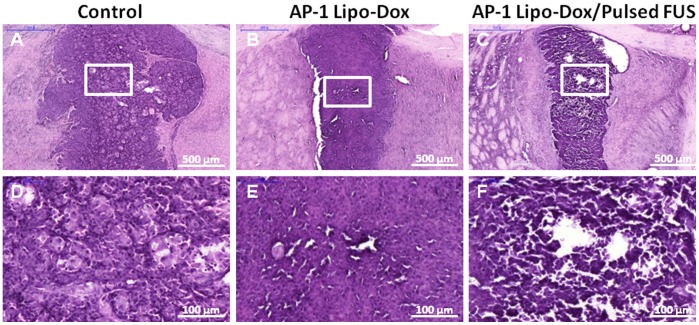
Twelve days after tumor implantation, three mice each form the control group, the targeted Lipo-Dox without pulsed FUS group, and the targeted Lipo-Dox with pulsed FUS group were sacrificed.Sections of the tumors were collected for hematoxylin and eosin histological examination. (scale bar = 500 µm [a-c]; scale bar  = 100 µm [d-f]).